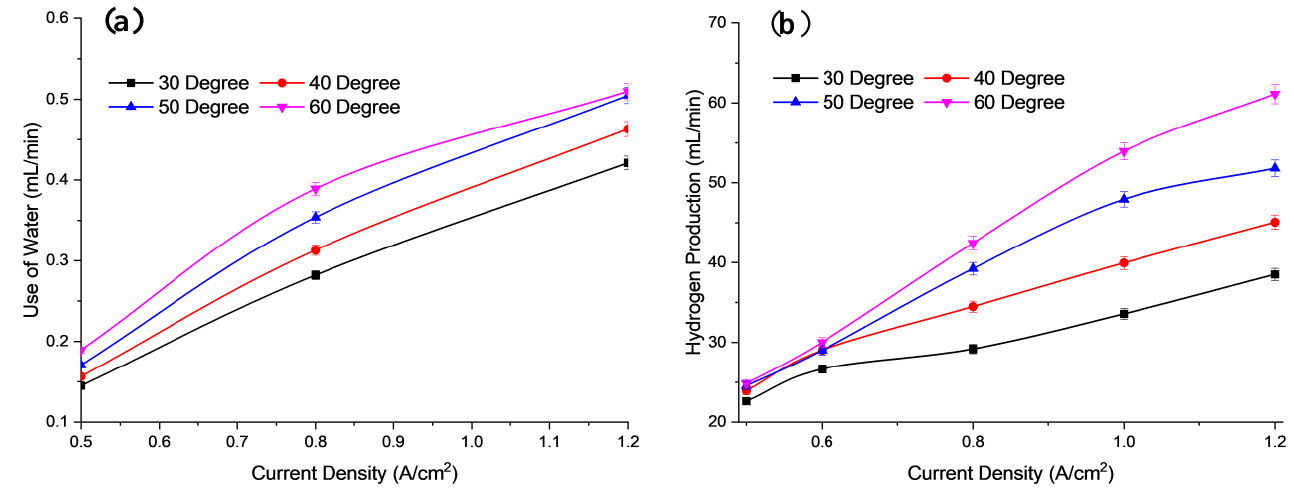
Figure 6. Profile of ( a ) use of water, ( b ) Hydrogen production based on electrolysis efficiency for different operating temperatures at 6 mL/min flow rate and concentration of electrolyte 2.0 M KOH.